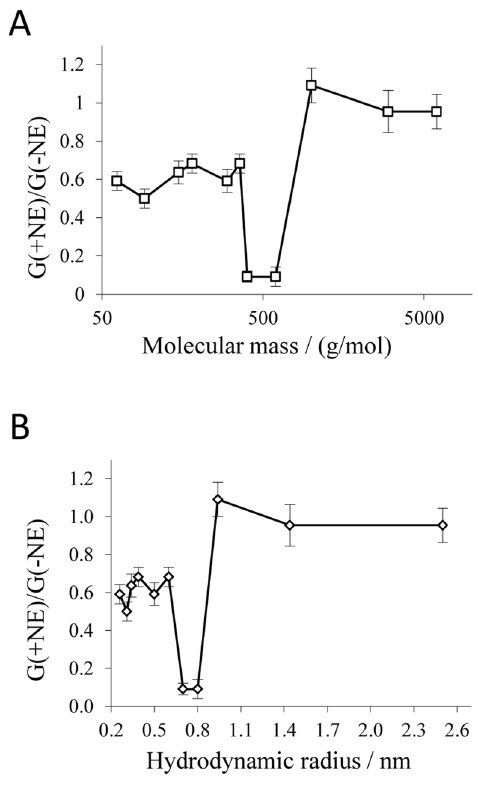
Figure 2. Dependence of the single-channel conductance of P66 on the molecular mass (A) and the hydrodynamic radius (B) of the nonelectrolytes. G ( + NE) /G ( 2 NE) is the ratio of the mean single-channel channel conductance in the presence of NEs (taken from table 1) to that in the absence of NEs (11.0 nS [1]). Molecular masses and hydrodynamic radii of the nonelectrolytes were taken from table 1. The bars indicate absolute errors.